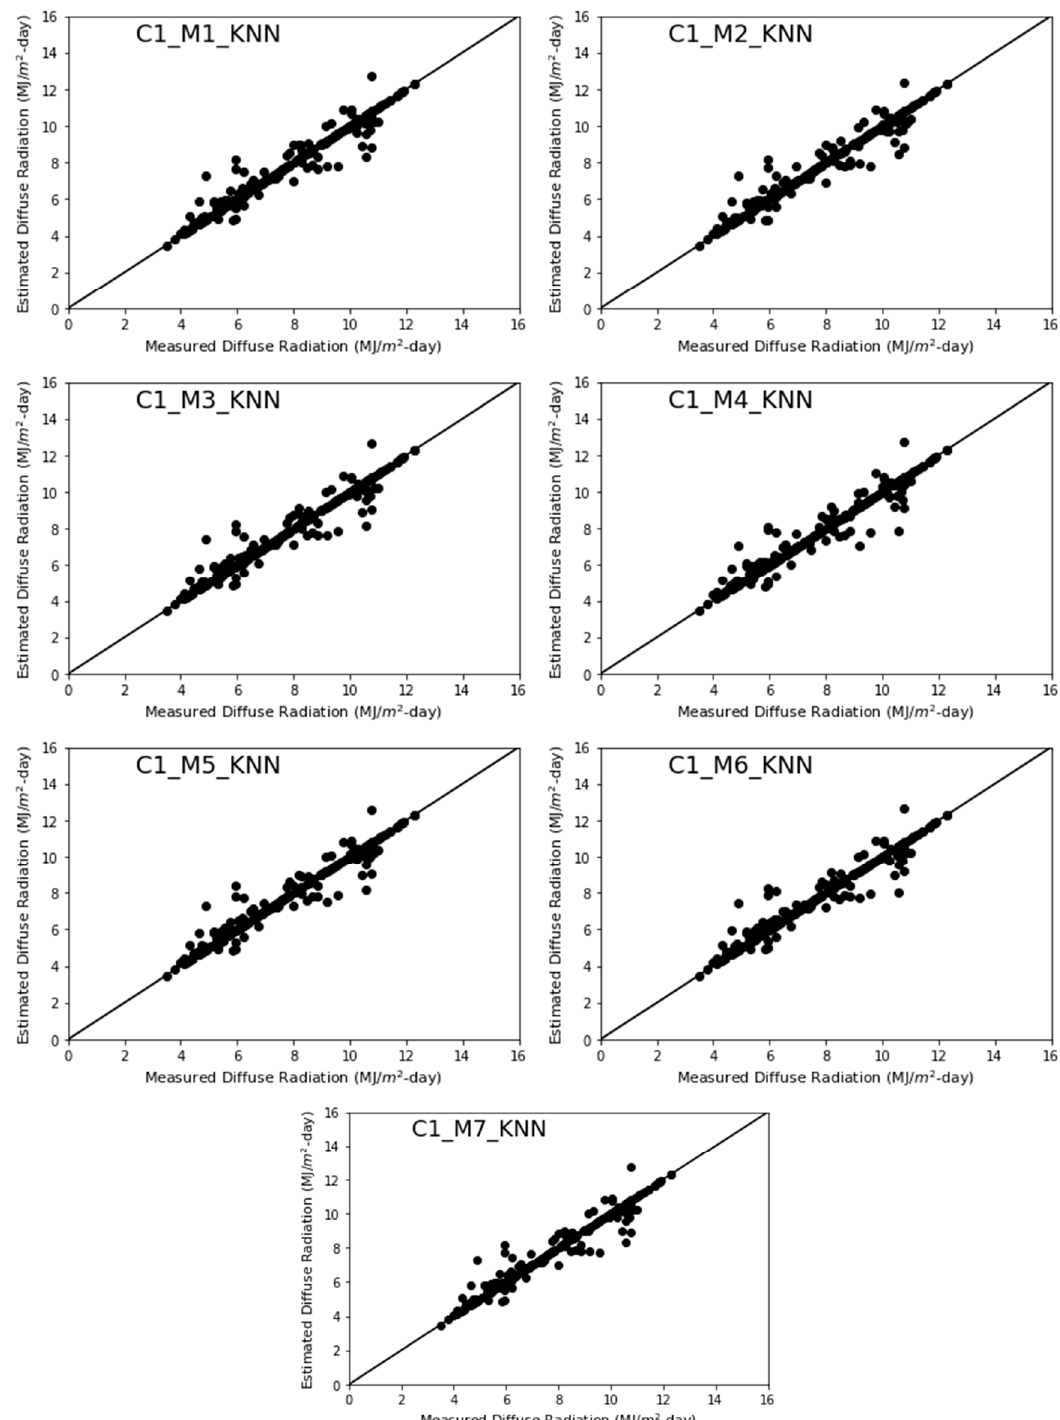
Figure 2. Plot depicting predicted and measured DSR from KNN ML models (Category 1).